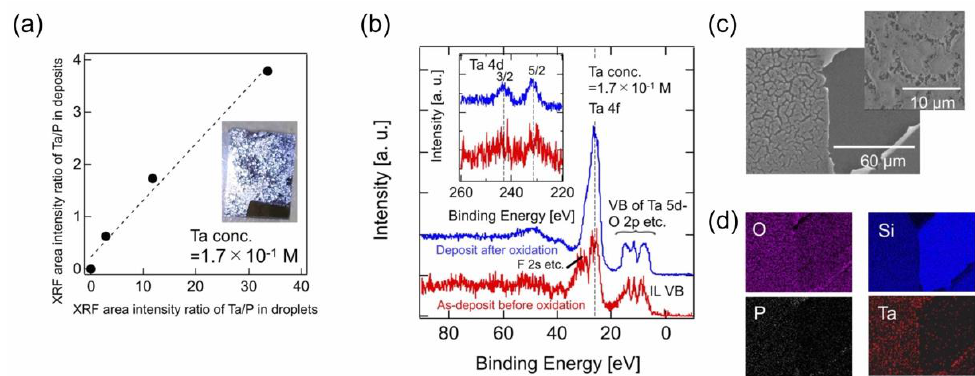
Figure 12. ( a ) XRF intensity ratio of Ta(Lα)/P(Kα) for the deposit plotted against that of the corre- sponding original IL solution. ( b ) XPS spectra of an IL deposit of the Ta ions-containing IL solution (1.7 × 10 − 1 M) on SiOx/Si(001) before and after the air-annealing treatment. ( c ) SEM image of the air-annealed sample of the IL deposit. ( d ) EDX elemental mapping of O, Si, P and Ta in the SEM. Reproduced with permission from ref. [66]. Copyright 2022, IOP Publishing Ltd.